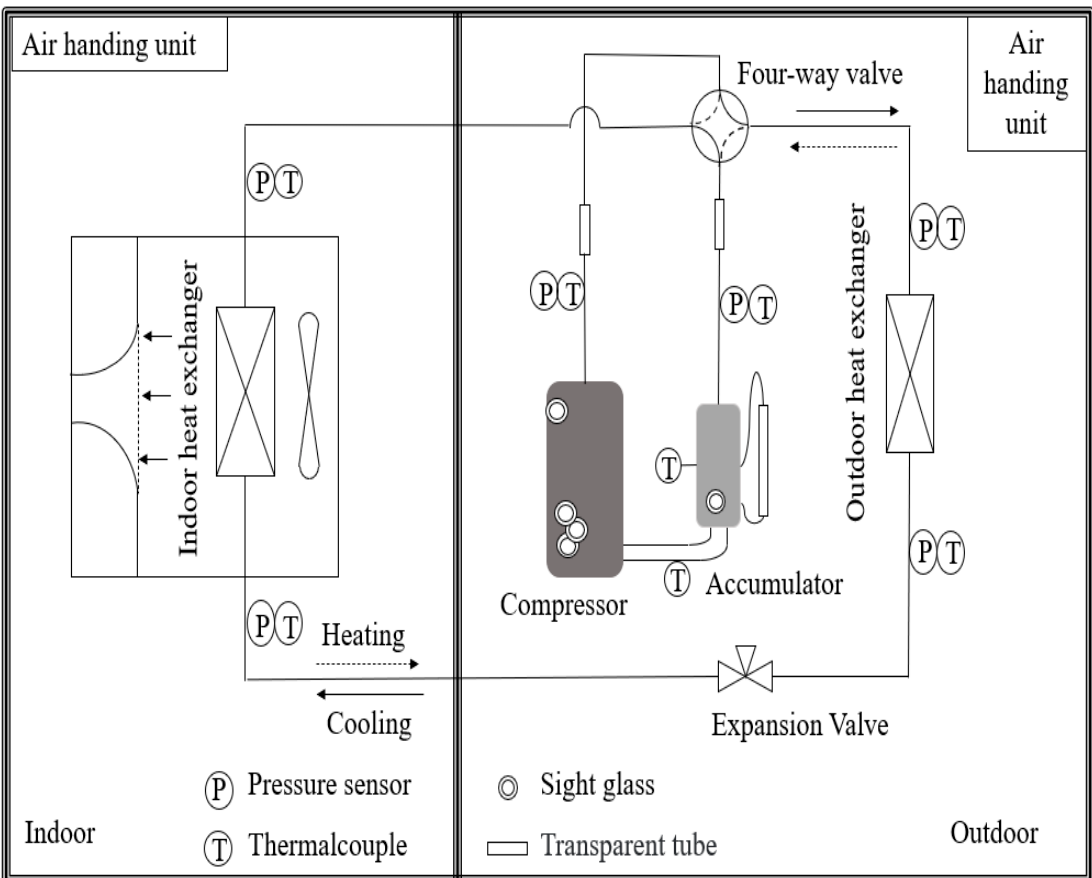
Figure 5. Schematic diagram of experimental setup.